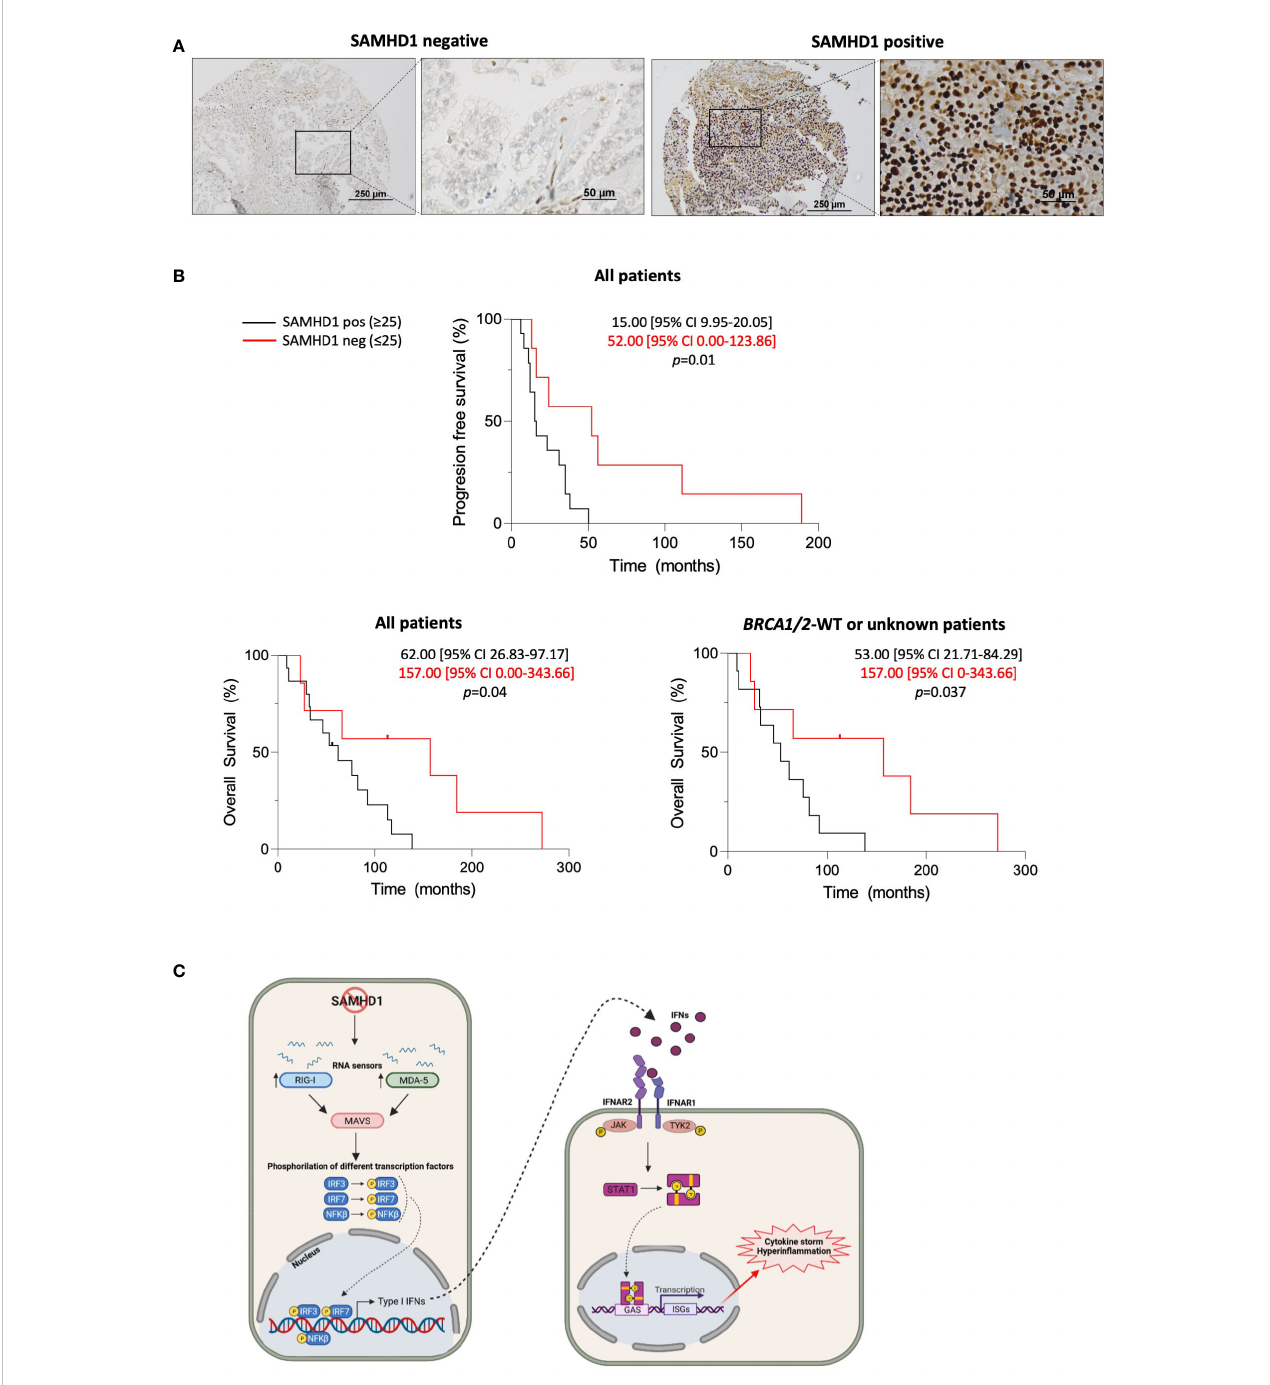
FIGURE 3 SAMHD1 expression is a prognostic factor in ovarian cancer patients. (A) Representative microscopy images of SAMHD1 expression in paraf fi n-embedded ovarian tumour biopsies. Images on the left represent SAMHD1-low expressing tumours and on the right positive expressing tumours. SAMHD1 expression was evaluated by immunohistochemistry in tumour samples. High expression of SAMHD1 observed in lymphocytic cells in fi ltrating in the tumours was used as a positive control of immunohistochemistry for negative or low expressing biopsies. (B) Kaplan-Meier curves of progression-free survival (PFS, top) and overall survival (OS, bottom) strati fi ed according to SAMHD1 status, i.e, SAMHD1-low (SAMHD1 expression below 25% in cancer cells, red lines) or SAMHD1-high (SAMHD1 expression equal or above 25%, black lines). Median survival times with 95% CI of both groups are shown. Log rank test was used to test the signi fi cance and censored patients are indicated by a vertical line. (C) Working model of the innate immune signalling pathways triggered by the absence or the low expression of SAMHD1 in ovarian cancer. Low SAMHD1 expression induces increased levels of distinct IFN-stimulated genes in ovarian cancer cells, subsequently leading to increased antitumoral immunity and better prognosis in patients. Abbreviations are as follows: MDA5, melanoma differentiation-associated protein 5; RIG-I, retinoic acid-inducible gene-I; IFN, interferon; IFNAR, interferon a/b receptor